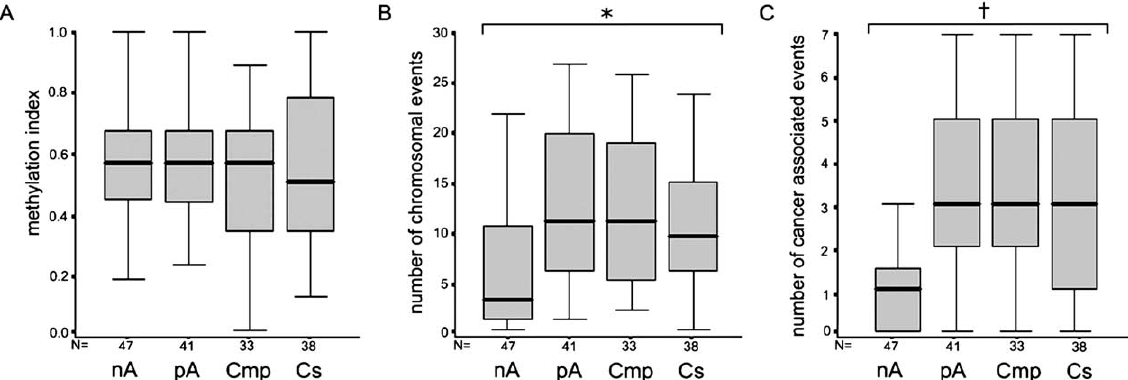
Fig. 1. Promoter methylation and chromosomal alterations in colorectal cancer development. nA = nonprogressed adenoma; pA = progressed adenoma; Cmp = carcinoma part of a malignant polyp; Cs = solitary carcinoma. (A) Promoter methylation has been analyzed for 9 DNA repair- and tumor suppressor genes. The methylation index (total number of methylated genes divided by the number of genes analyzed) stays stable during tumor development, while (B) the total number of chromosomal alterations (chromosomal events), analyzed on genomic level, and (C) the number of cancer associated events (losses at 8p21-pter, 15q11-q21, 17p12-13, 18q12-21, and gain at 8q23-qter, 13q14-31 and 20q13) increase. * P value: 4 . 1 × 10 − 6 , † P value: 3 . 6 × 10 − 10